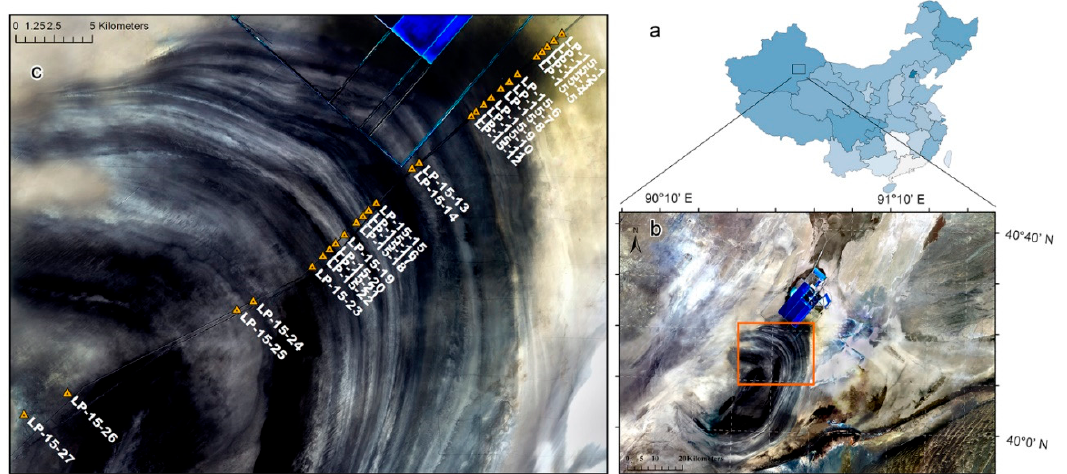
Figure 1. Images of the study area. Image from a GF-1 [13] multispectral camera with eight-meter spatial resolution (R: Band 3, G: Band 2, B: Band 1) to show ( a ) the position of the Lop Nur Basin within China, and ( b ) a global view. The orange grid marks the range extension of the image in ( c ), a map of our sampling sites distributed alongside a road. Moving from the edge to the center, these sites are numbered in order from LP-15-1 to LP-15-27.